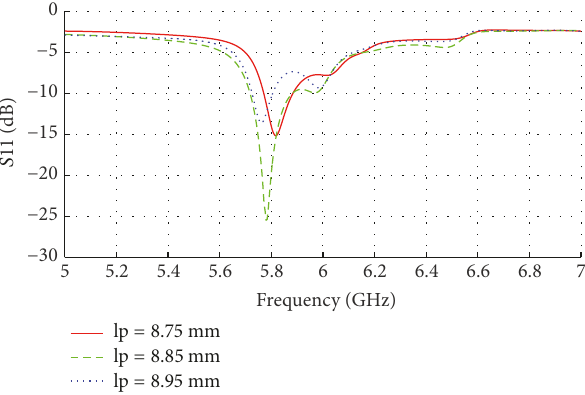
Figure 7: The optimization of length of the radiation